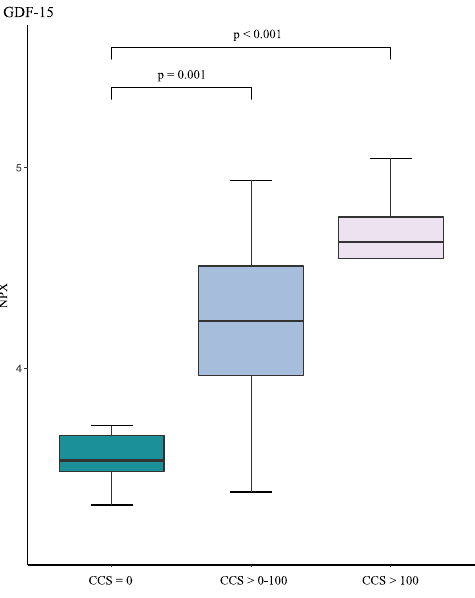
Figure 3. Distribution of growth differentiation factor-15 (GDF-15) between subjects with coronary artery calcium score (CCS) = 0, CCS > 0–100, and CCS > 100 in patients without cardiovascular disease and statin treatment (n = 34). NPX normalized protein expression.